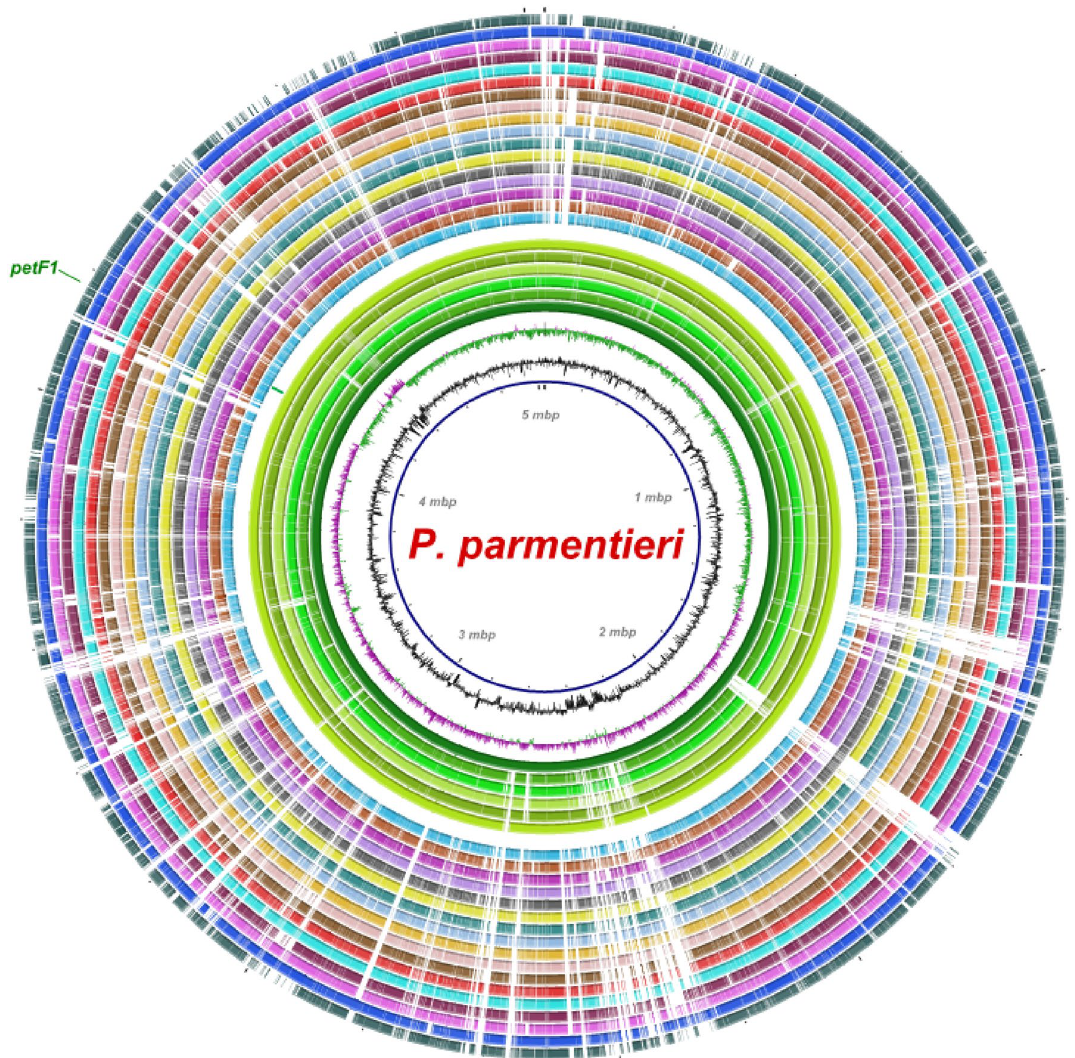
Figure 1. Locus representation of the target gene petF1 (ferredoxin) used for the specific detection of Pectobacterium parmentieri . The BLAST ring image was generated using the BRIG software 29 . The circular graphic shows the multiple alignment and genome comparison of six P. parmentieri strains and the other seventeen species that currently encompass the Pectobacterium genus. The three innermost layers in the graphic portray the genome coordinates (mega base pairs— mbp ), GC content (zigzag black line) and GC skew (purple + /green − zigzag) of the P. parmentieri RNS 08-42-1A reference genome. The other colored rings, from the innermost to outermost, depict the nucleotide BLAST alignment of P. parmentieri RNS 08-42-1A (NZ_CP015749), P. parmentieri SCC3193 (NC_017845), P. parmentieri WPP163 (NC_013421), P.